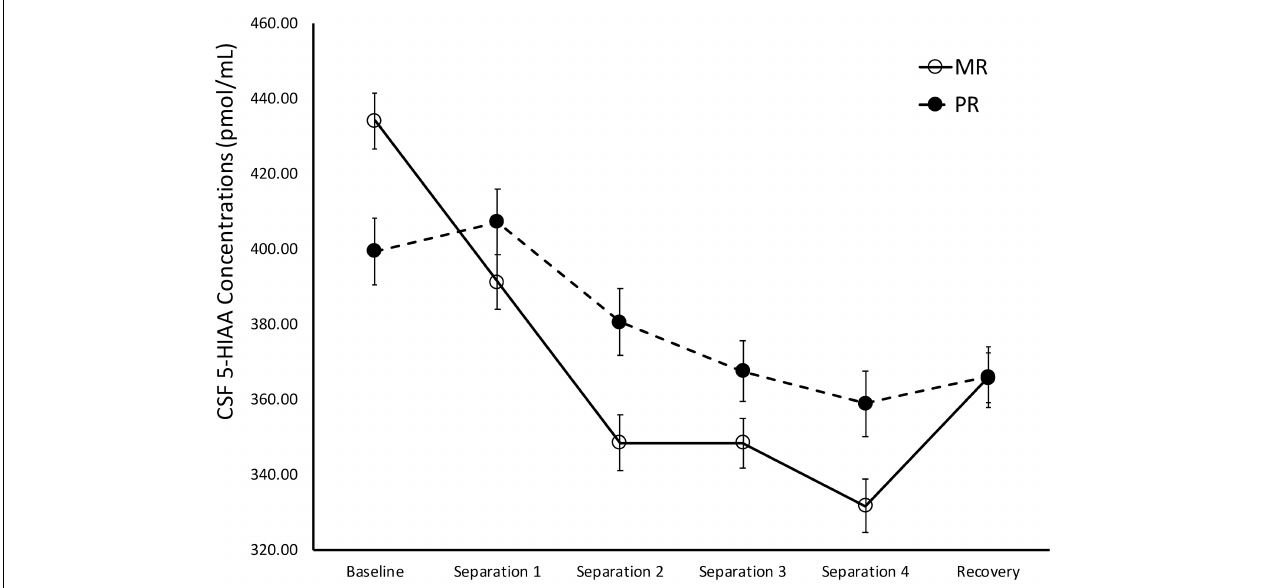
FIGURE 2 | Rearing effects on baseline and stress-induced CSF 5-HIAA concentrations. Depicts the relationship between rearing condition and CSF 5-HIAA concentrations during Baseline, Separations 1–4 , and Recovery . There was a significant main effect of time on CSF 5-HIAA concentrations [ F (1,173) = 111.43, p < 0.0001], with CSF 5-HIAA concentrations higher during Baseline and Separation 1 , when compared to Separations 2–4 or Recovery . There was also a significant two-way separation-by-rearing condition interaction on CSF 5-HIAA concentrations [ F (1,176) = 6.05, p = 0.02], with MR subjects exhibiting higher CSF 5-HIAA concentrations during Baseline , but lower CSF 5-HIAA concentrations during Separations 1–4 , when compared to PR subjects. MR subjects are represented by white circles and solid lines, PR subjects are represented by black circles and dashed lines.